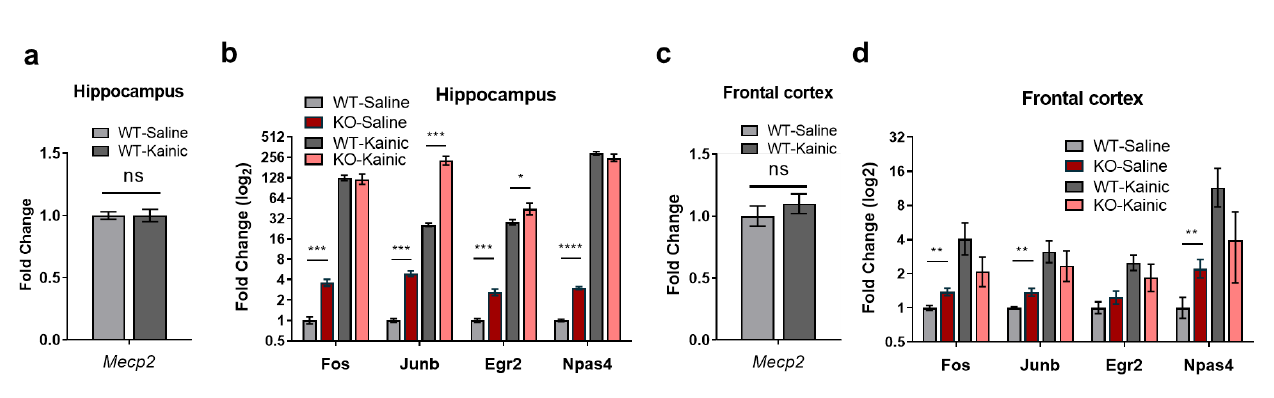
Egr2 are impaired in the hippocampus of a RTT mouse model.